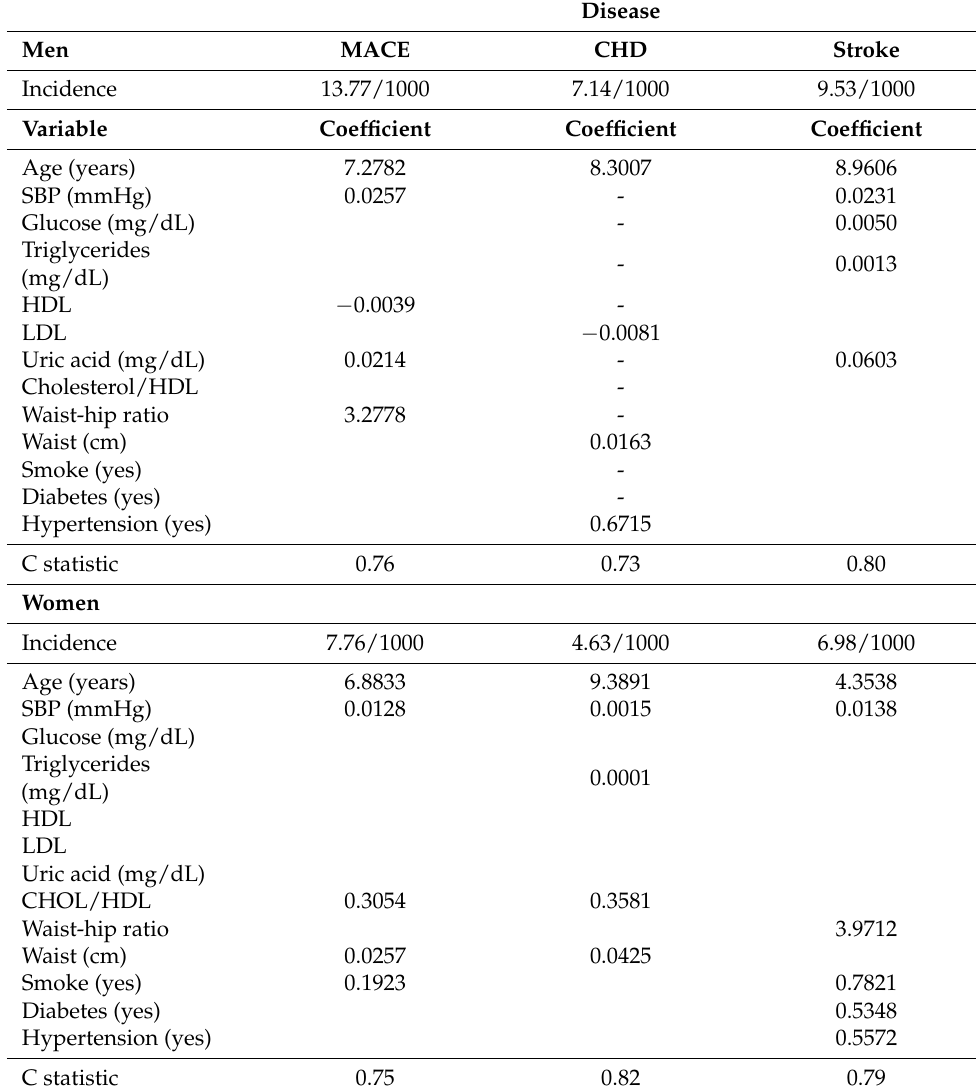
Table 2. Variables used in the models for each disease by